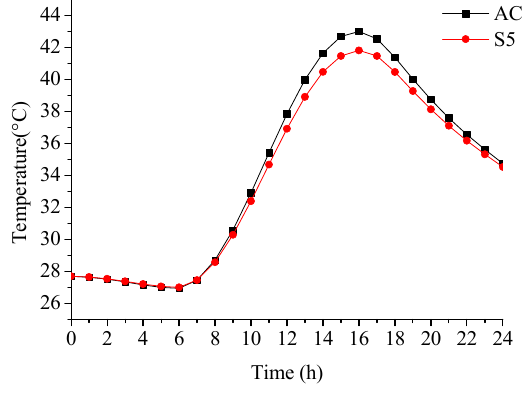
Figure 10. Temperature at the bottom of the middle surface.